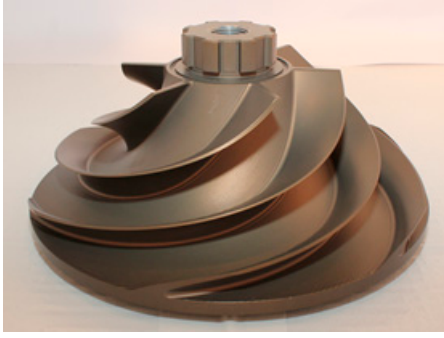
Figure 4. VAMPUFF radial impeller.